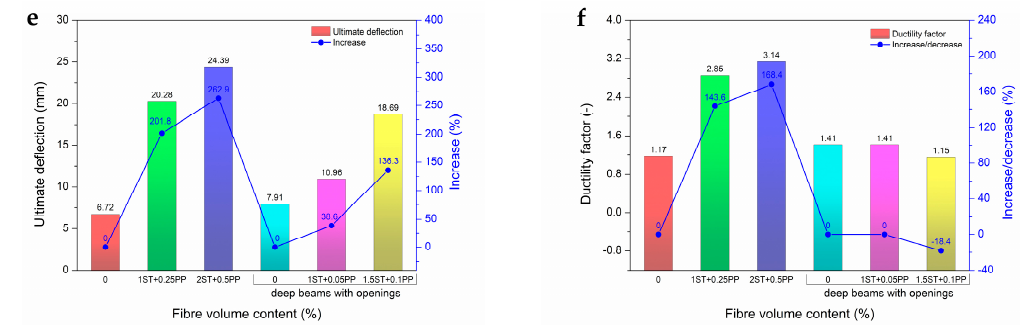
Figure 17. Comparison of deep beam ( a ) initial stiffness; ( b ) over-strength factor; ( c ) pre-peak energy; ( d ) post-peak energy; ( e ) ultimate deflection and ( f ) ductility factor.